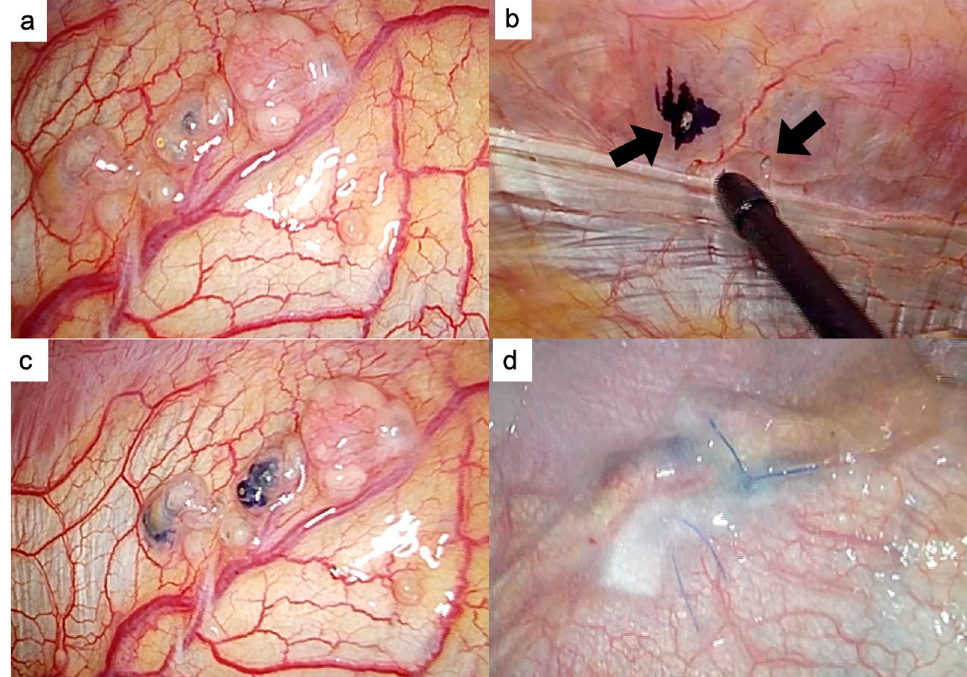
Fig. 4 Surgical findings of case 4. a Thinned diaphragm and cystic lesions were detected at the central tendon of the diaphragm. No pores or bubbles due to laparoscopic pneumoperitoneum were observed on the diaphragm on the thoracic side. b Laparoscopic view of the diaphragmatic fistulas. Two small fissures with a diameter of 1 mm were detected on the abdominal side; we soaked the dye containing indigo carmine into the pores in the peritoneal cavity. c Two lesions with blue staining were noted on the diaphragm from the thoracic side. d Each lesion was closed with a 4–0 non-absorbable monofilament and Teflon pledget, with single U suture. Furthermore, the lesions were covered with a sheet of absorbable polyglycolic acid felt and sprayed with fibrin glue on the thoracic